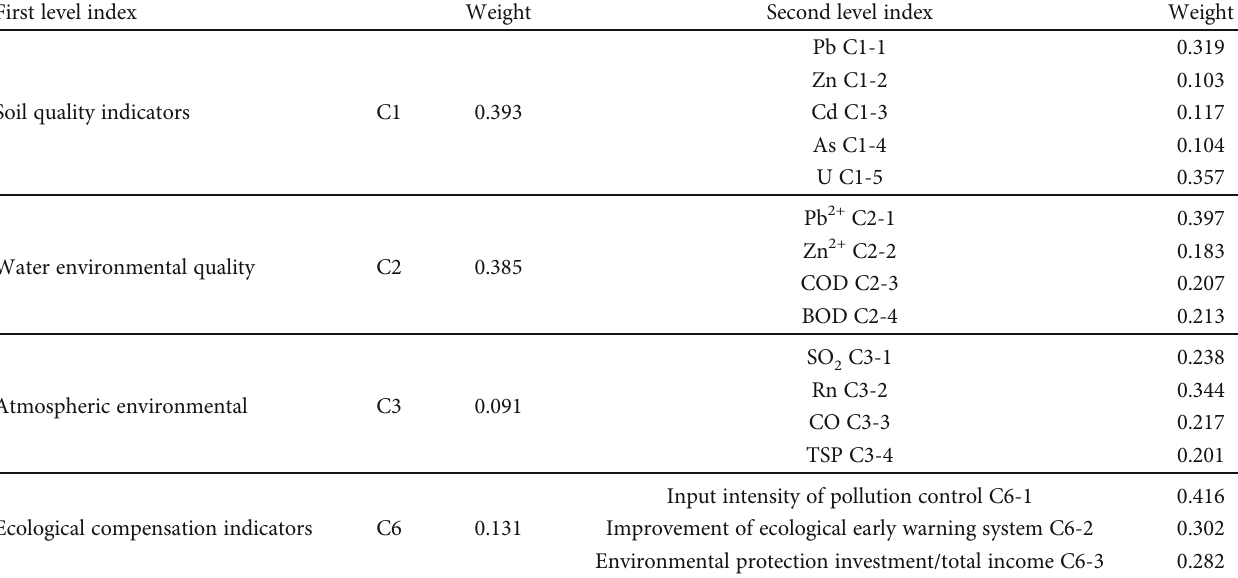
Table 4: Importance of indicators at all levels to objectives.